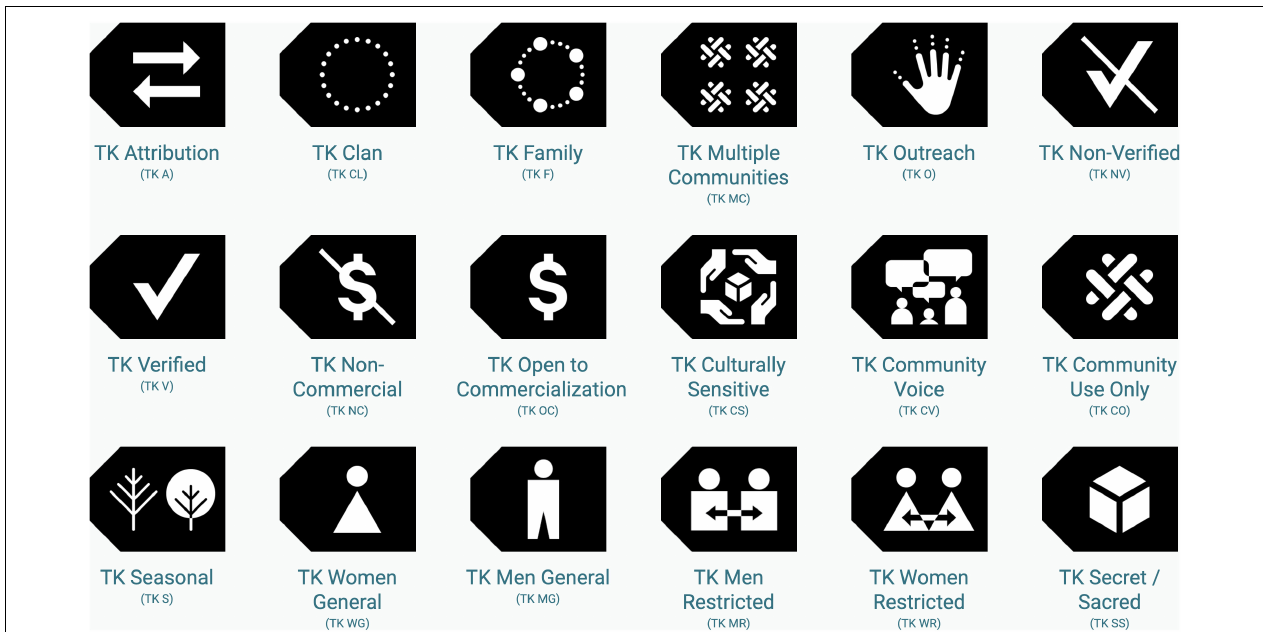
FIGURE 5 | The TK Labels are a tool for Indigenous communities to add existing local protocols for access and use to recorded cultural heritage that is digitally circulating outside community contexts. The TK Labels offer an educative and informational strategy to help non-community users of this cultural heritage understand its importance and significance to the communities from where it derives and continues to have meaning. Screenshot from localcontexts.org on June 11,